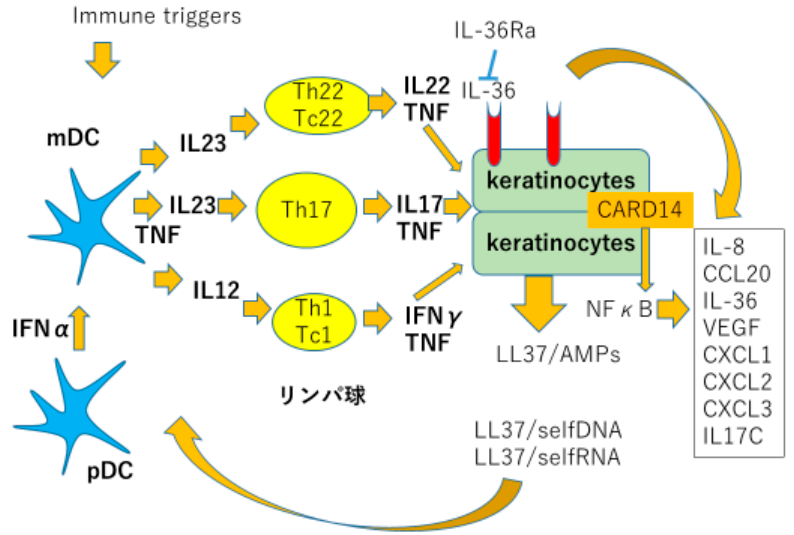
Figure 1. Pathogenesis of psoriasis. Modified from Lowes M.A. et al. Trends in Immunol 2016 [4]. External immune triggers, LL37 bound to self-DNA or RNA activate plasmacytoid and myeloid dendritic cells (pDC and mDC). Activated plasmacytoid cells produce type 1 interferons, and myeloid dendritic cells produce TNF α , iNOS, and IL-23, which activate Th17 cells to produce IL-17 and IL-22. IL-17 and IL-22 induce proliferation, production of cytokines, chemokines and antimicrobial peptides from epidermal keratinocytes, thus resulting in psoriatic phenotype.